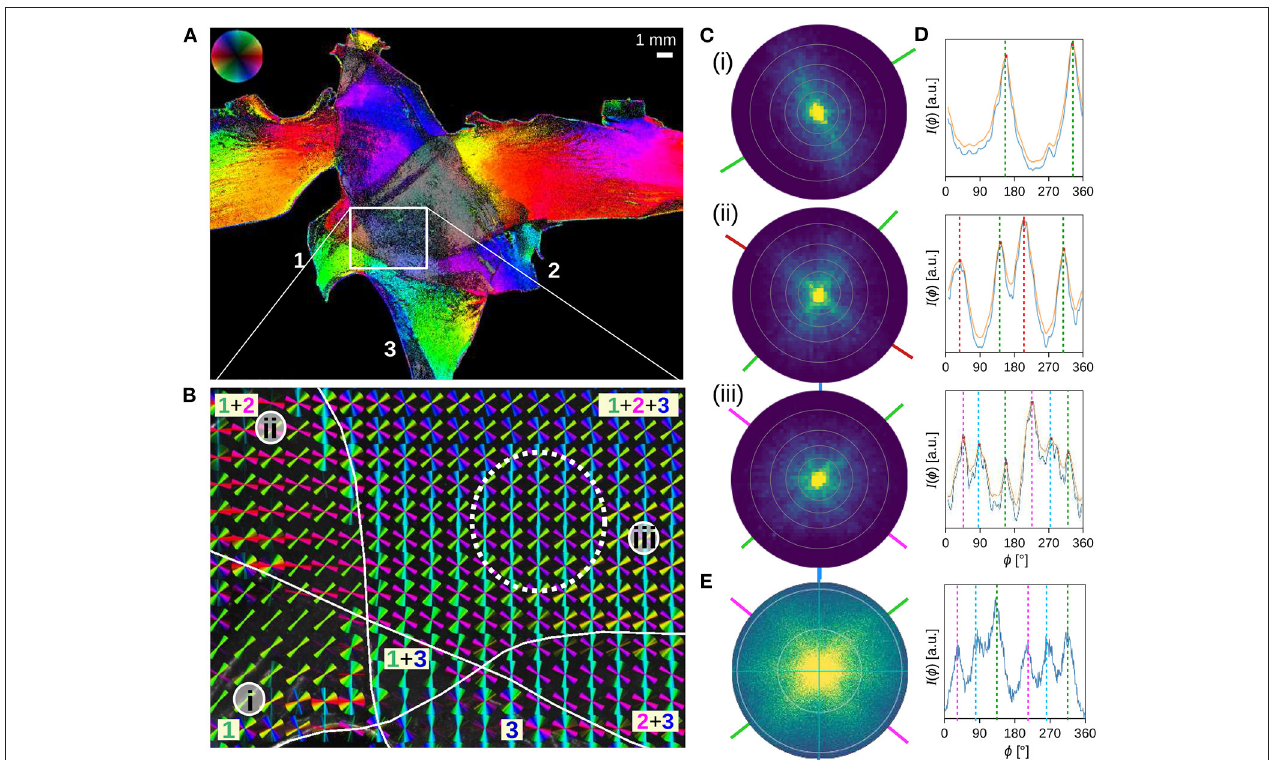
FIGURE 5 | Three crossing sections of human optic tracts were measured with angular/scatterometry SLI. (A,B) In-plane fiber orientations obtained from an angular SLI measurement with 15 ◦ azimuthal steps, 1 s illumination, and px = 6.5 µ m, performed 4 months after tissue embedding (as shown in Menzel et al., 2021, Figure 5, bottom). The fiber orientations are shown for each image pixel in different colors (A) , and for 40 × 40 image pixels together as colored lines (B) . The three tissue layers are marked by Arabic numbers. (C,D) Scattering patterns and corresponding (smoothed) azimuthal line profiles obtained from an SLI scatterometry measurement of the same sample (2 × 2 illuminated LEDs, 50 × 50 kernels, gain factor 10, illumination 5 s, 15 months after tissue embedding), evaluated exemplary for image pixels located in one (i), two (ii), and three (iii) tissue layers, at the positions indicated in (B) . The concentric rings in the scattering patterns denote steps of 1θ = 10 ◦ . The dashed vertical lines in (D) indicate the determined peak positions from which the nerve fiber orientations were computed (indicated by solid lines in C in the respective color). (E) Scattering pattern and corresponding azimuthal line profile obtained from a coherent Fourier scatterometry measurement for the region marked by the dashed white circle in (B) (adapted from Menzel and Pereira, 2020, Figure 5iv; the measurement was performed with a laser with 1.12mm diameter, a numerical aperture of 0.4, and 4 months after tissue embedding).